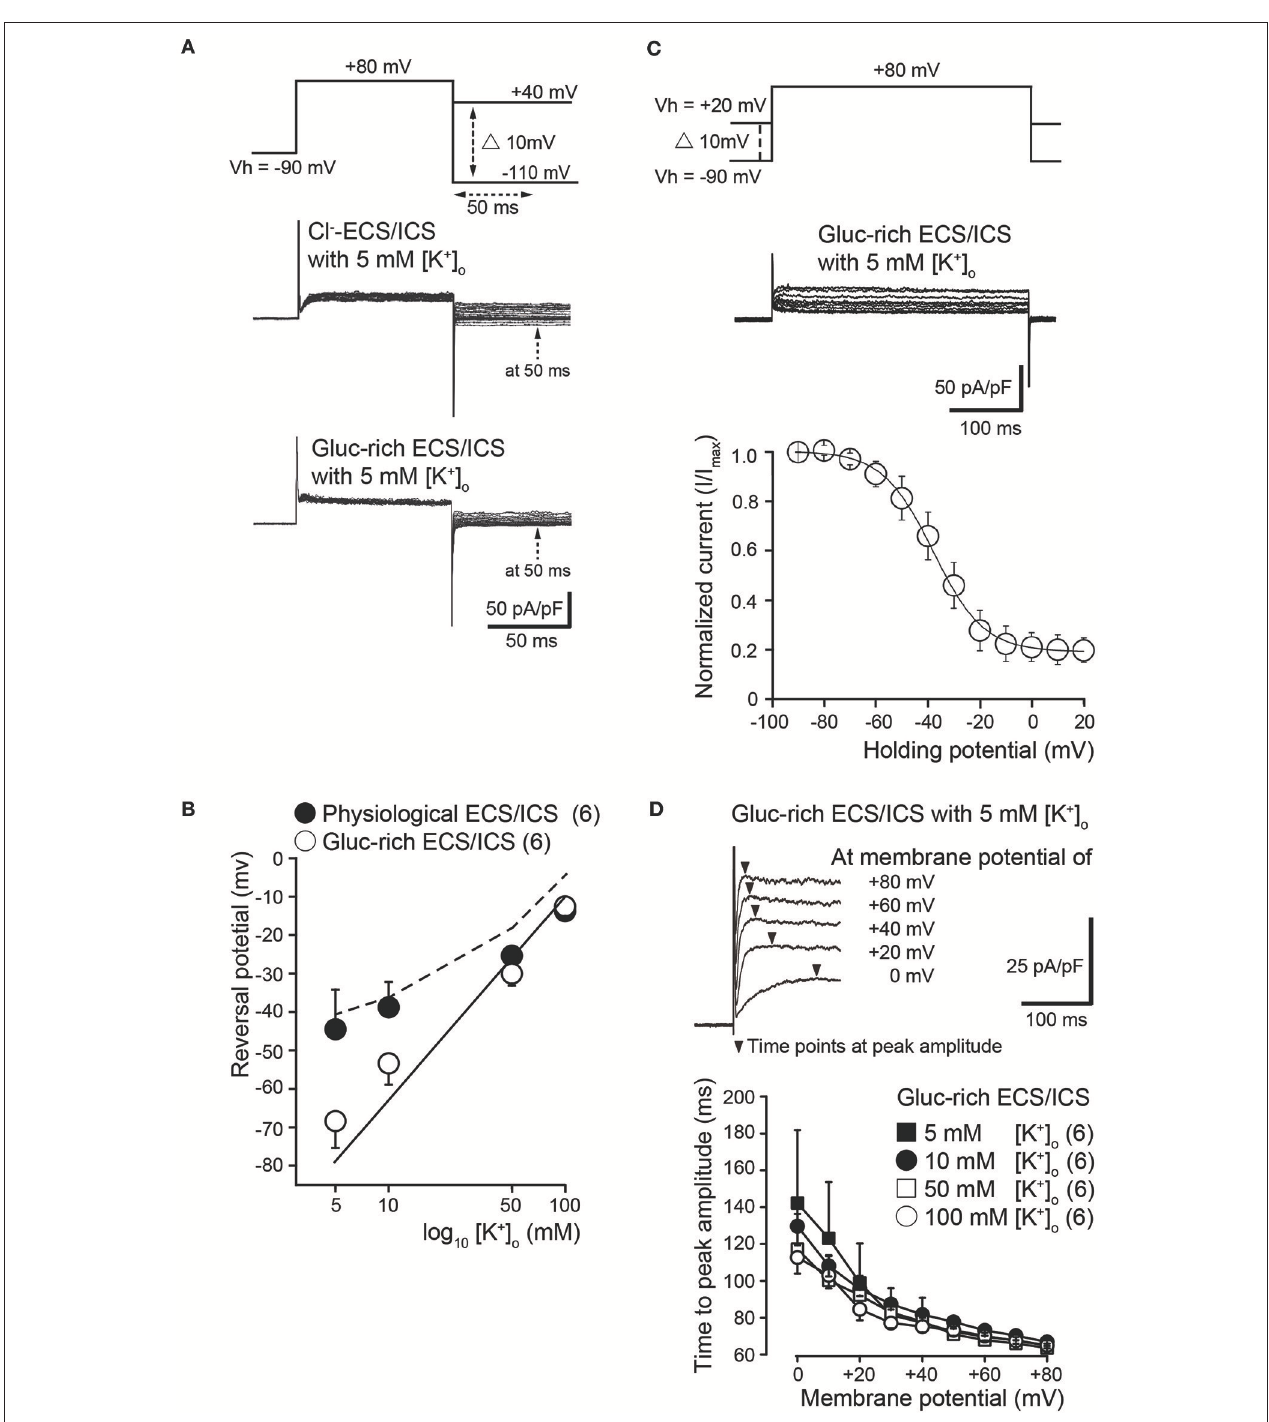
FIGURE 2 | Biophysical properties of outward currents in odontoblasts. (A) Representative current traces recorded under conditions of Cl − -rich ECS and ICS (middle traces) as well as gluc-rich ECS and ICS (lower traces) are shown. Currents were elicited by voltage steps from a Vh of − 70mV to + 80mV before hyperpolarizing in 10mV increments ranging from − 110 to + 40mV (upper traces). To analyze the values of reversal potential, we measured the amplitudes at 50ms (dashed arrows in both the middle and lower) after initiating hyperpolarized voltage pulsing (dashed double headed arrow in upper) under both conditions. (B) Semilogarithmic plots of reversal potential against various [K + ] o (5–100mM) under Cl − -rich physiological (filled circles) and gluc-rich (open circles) conditions are shown. The reversal potentials under gluc-rich conditions were closely fitted to expected values, which were estimated for pure K + conductance described by the Nernst equation (solid line).